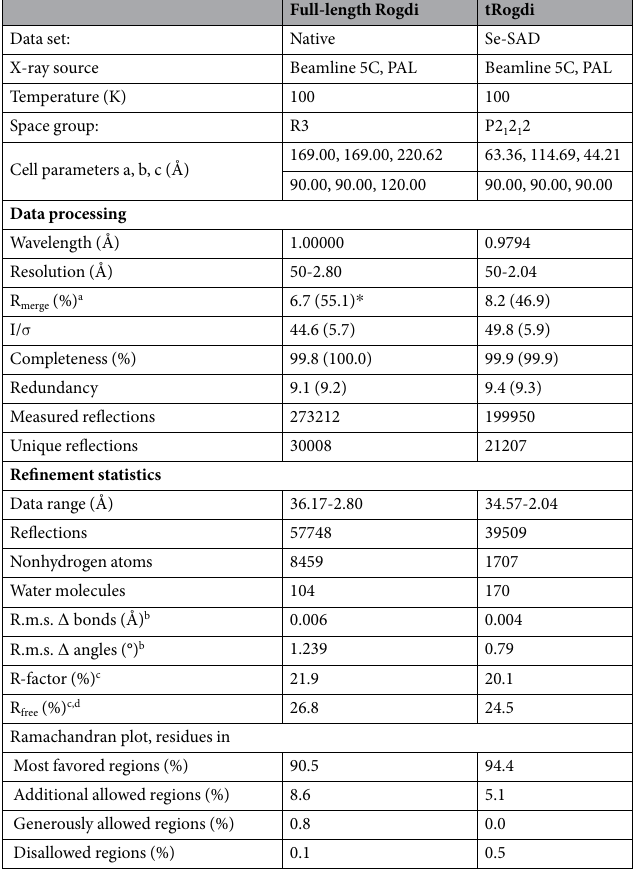
Table 1. Data Collection and Refinement Statistics. * Highest resolution shell is shown in parenthesis. a